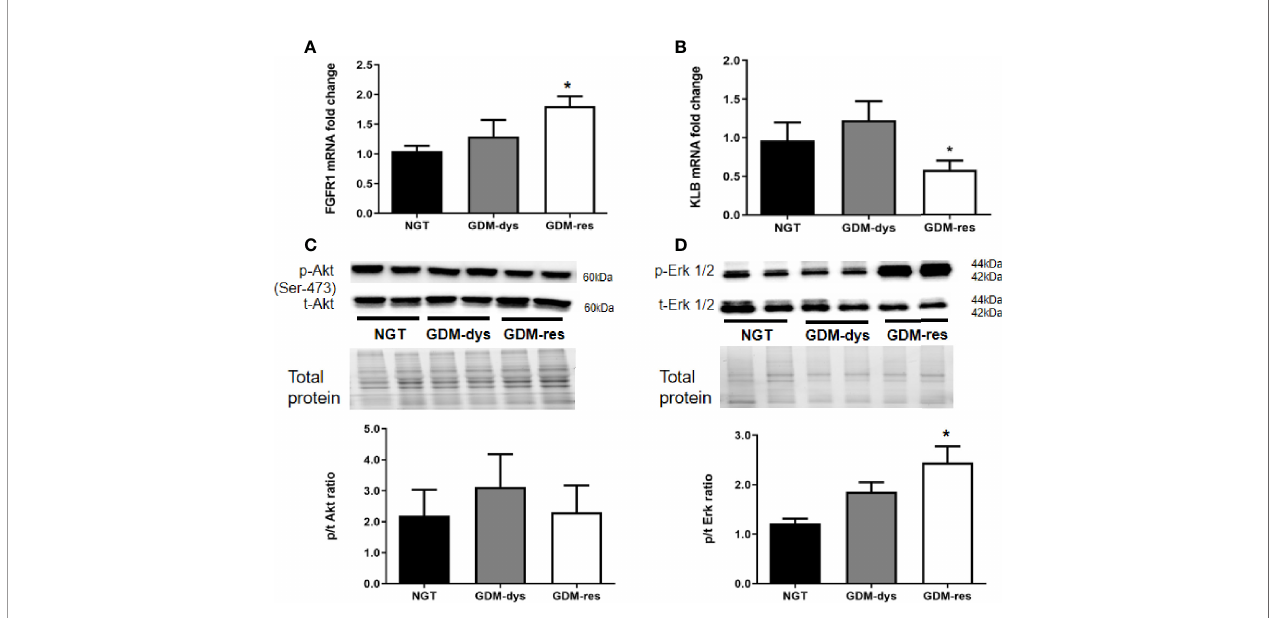
FIGURE 2 | Relative gene and protein expression of FGF21 receptors and signaling pathways in vWAT. (A, B) Gene expression of FGFR1 and KLB. (C, D) Protein expression of phosphorylated/total Akt (Ser 473) and Erk1/2 (T202/204). * P < 0.05 vs. NGT group. Data were analyzed by a one-way ANOVA with Tukey post hoc test. NGT, n = 13; GDM-res, n = 17; GDM-dys, n =